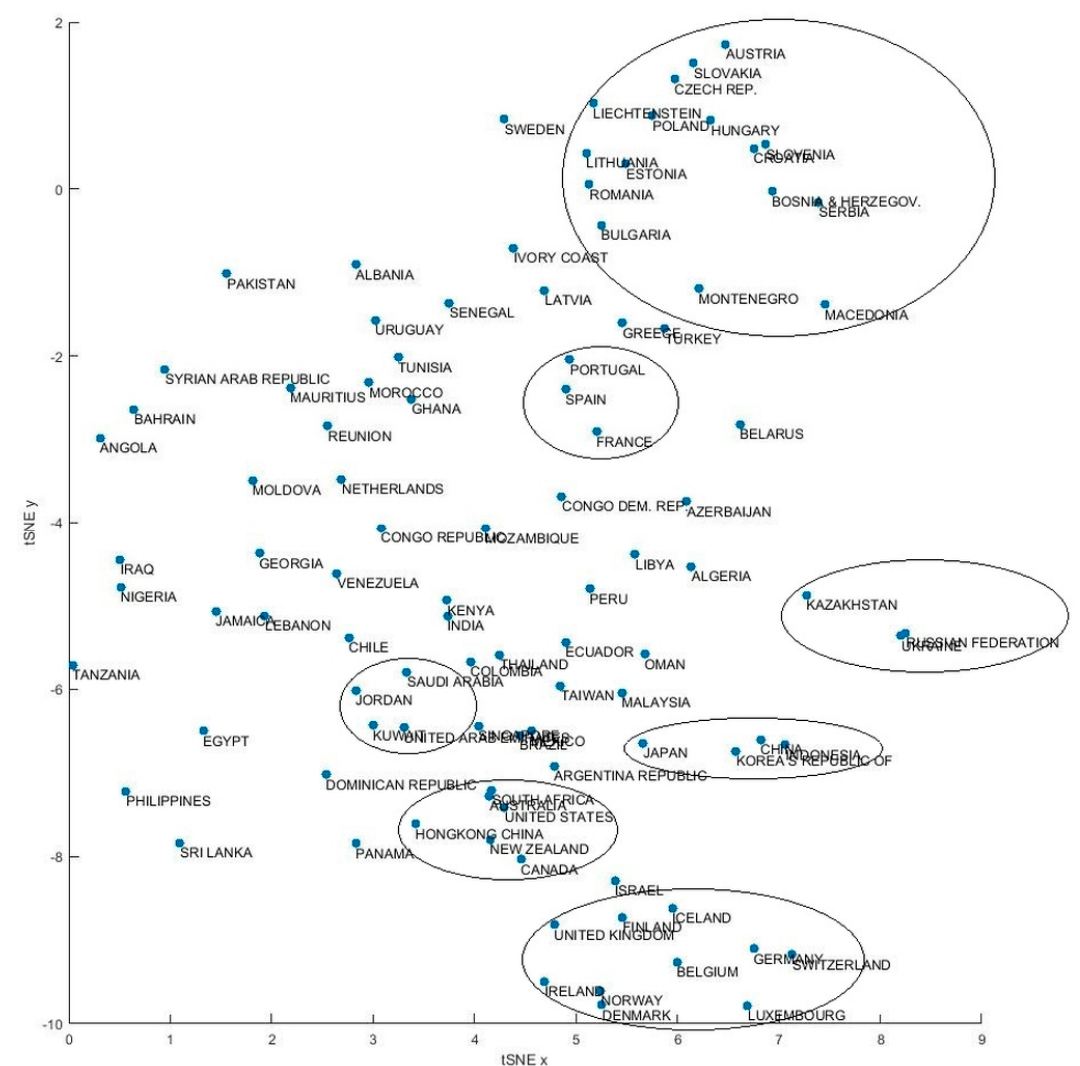
Figure 17. t-SNE reduction of the embedding vectors representing the motion behavior of visitors’ main nationalities in Italy.